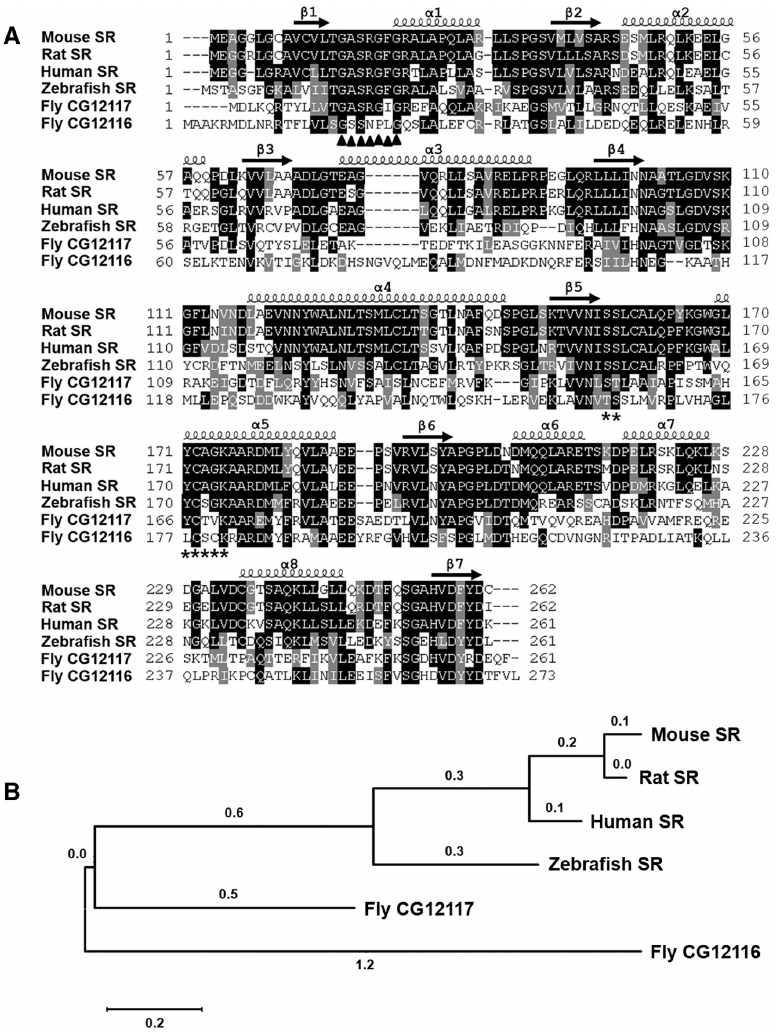
Figure 1: Multiple sequence alignment of SR homologues. (A) The amino acid sequence alignment of SR homologues from five species was performed using the ClustalW2 program. Strictly conserved residues are shaded in black, and similar residues are colored gray. The NADP(H)-binding site in the N-terminus and the catalytic site in the C-terminus are represented by black triangles (▴) and asterisks ( * ), respectively. The representative position of the α -helix (curved lines) and β -sheet (black arrow) is shown above the alignment. The amino acid sequences are mouse SR ( Mus muculus , NP_035597.2), rat SR ( Rattus norvegicus , NP_062054.1), human SR ( Homo sapiens , ( Drosophila melanogaster , NP_572481.1). The figure was drawn using the BoxShade server. (B) Phylogenetic analysis of six SRs. Protein sequences were aligned using ClustalW2, and the phylogenic tree was constructed by the MEGA 6.0 program, using the maximum- likelihood method. The genetic distances are displayed on each internal branch.